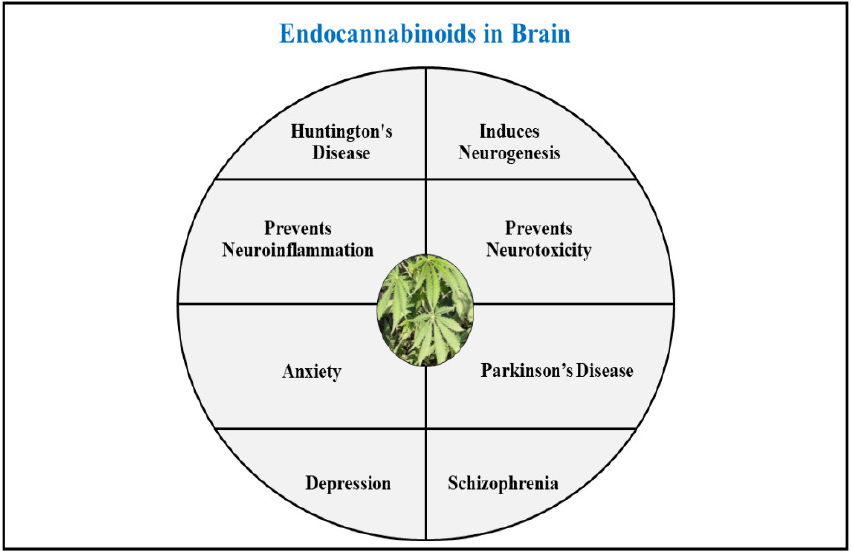
Figure 5. A general overview of the beneficial roles presented by endocannabinoids in brain.